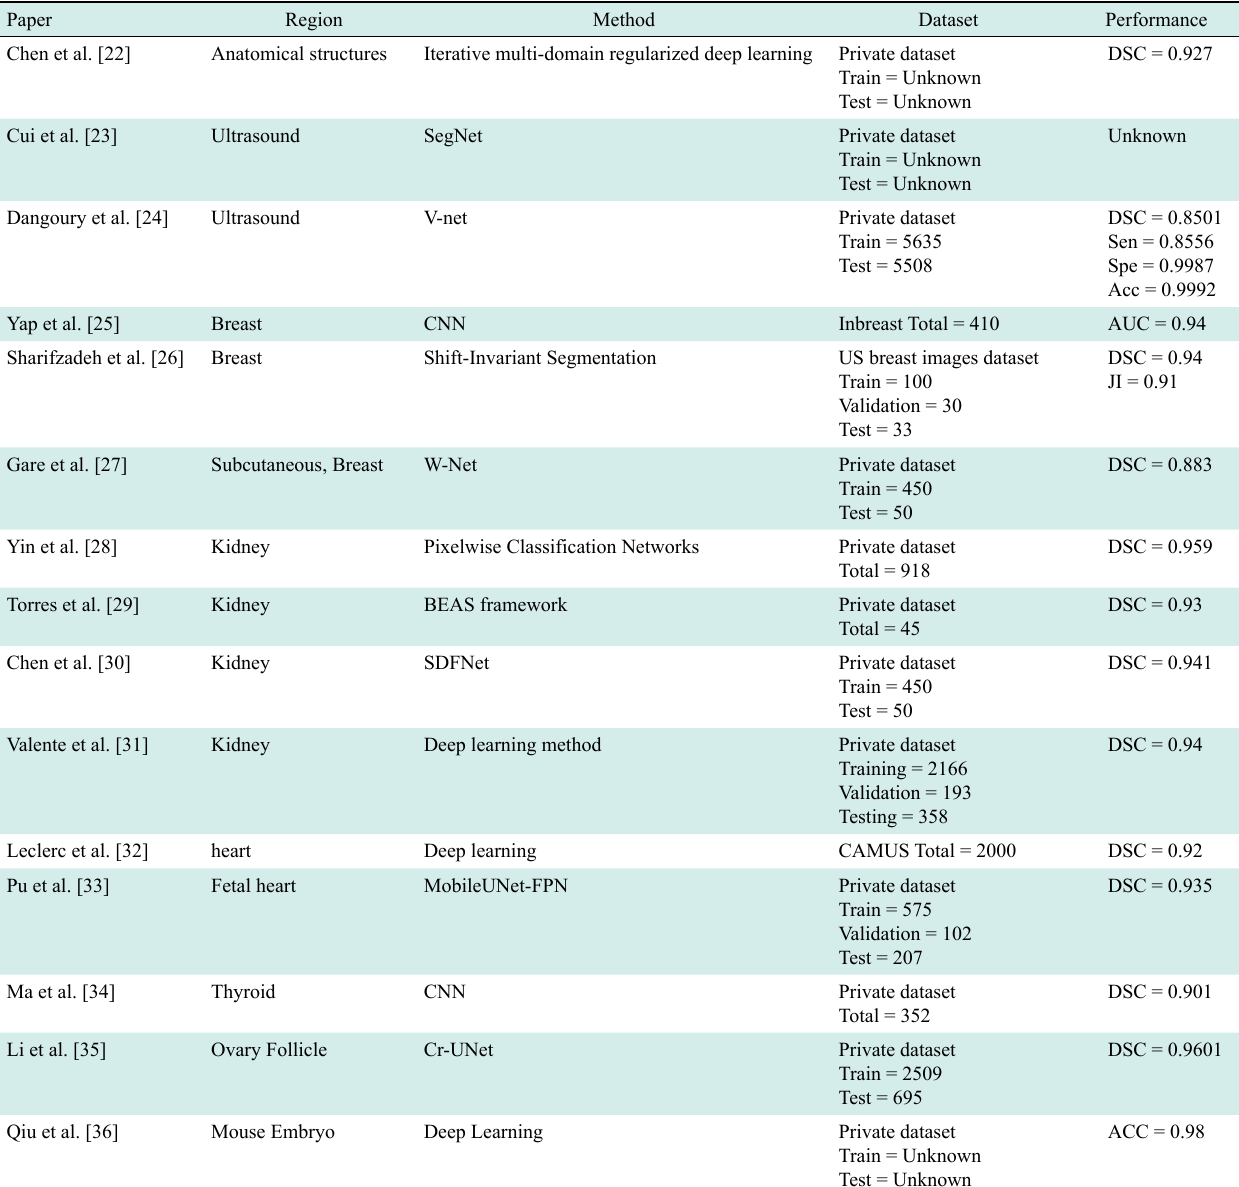
Table 2 Summary the region of interest, method, dataset, and performance of the major researches on AI in medical ultrasound segmentation in recent years